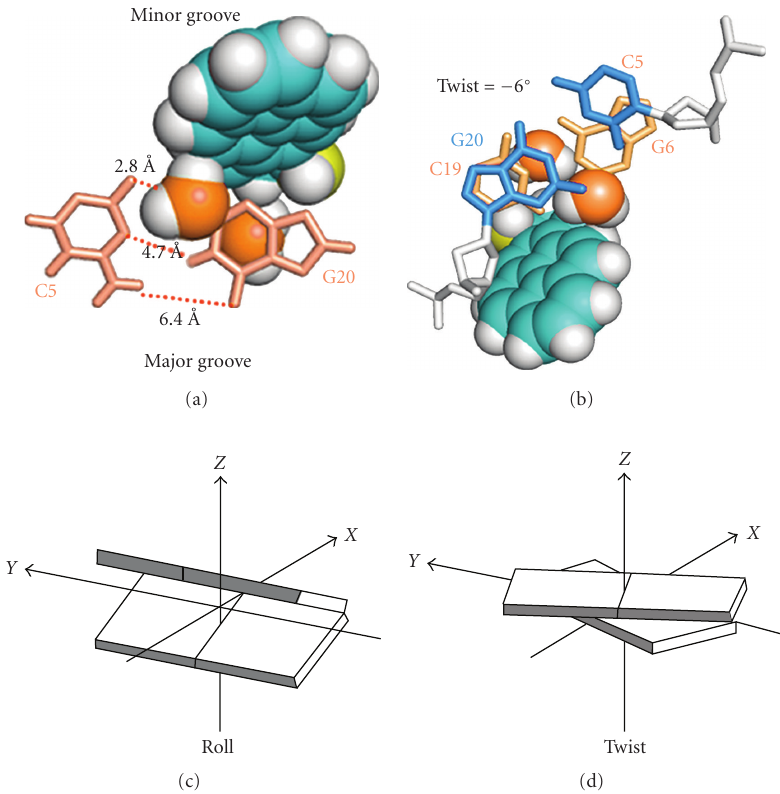
Figure 3: (a) In the 5 (cid:3) - ... C[G ∗ ]G ... sequence context, steric hinderance between the B[ a ]P moiety and nearby guanine amino groups causes the episodic denaturation of the C5:G20 Watson-Crick hydrogen bond. (b) In the 5 (cid:3) - ... G[G ∗ ]C ... sequence context, steric hindrance between the B[ a ]P moiety and nearby guanine amino groups causes untwisting, manifested as a bend. (c) and (d) Definition of DNA duplex helicoidal parameters Roll and Twist , respectively. These cartoons are adapted with permission from Lu et al., Nucleic Acids Res. 31 (17): 5108 − 5121, Figure 1, Copyright 2003, Oxford University